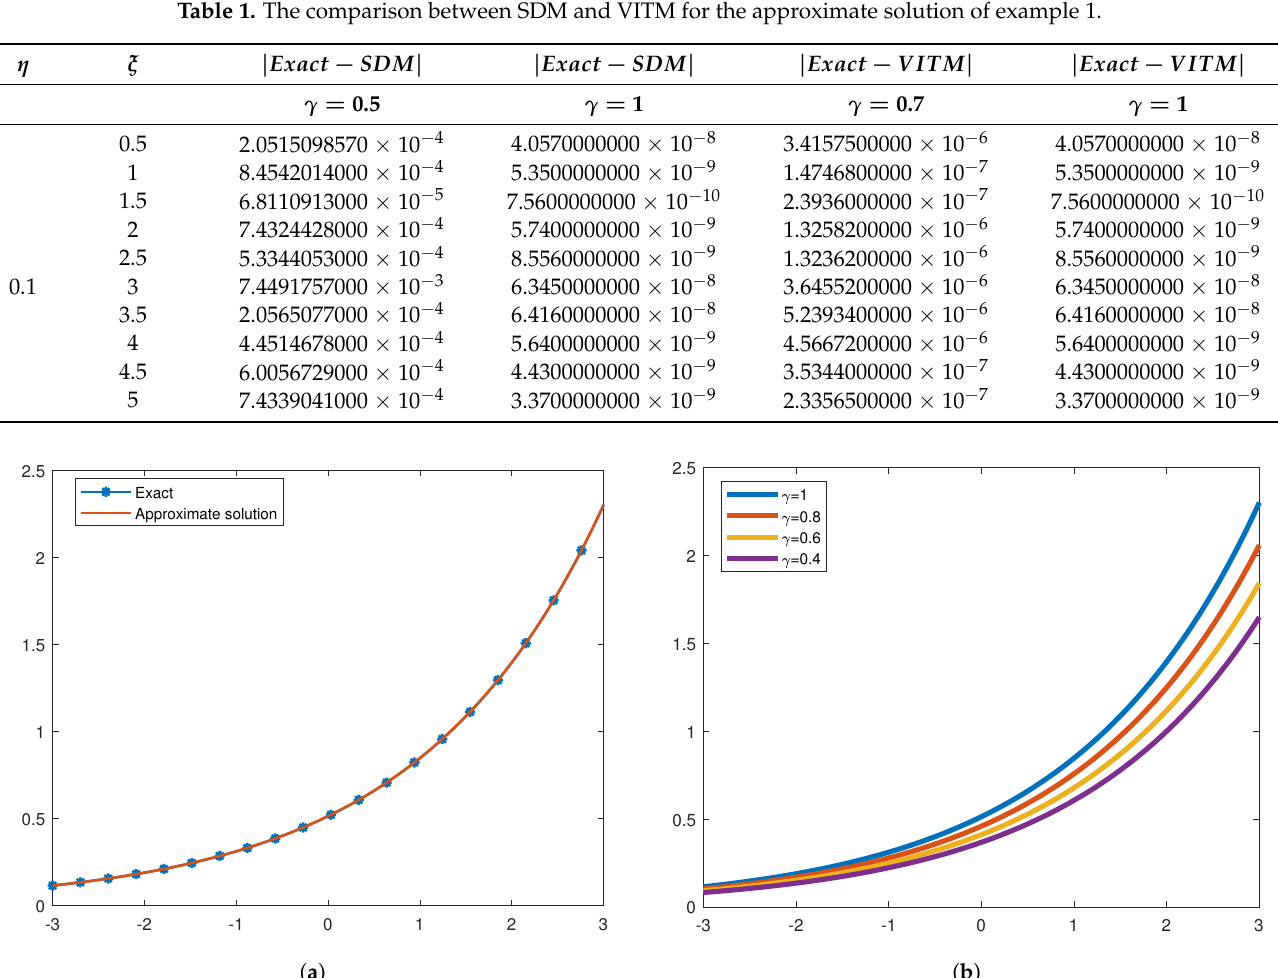
Figure 1. ( a ) Exact and approximate solution plot at γ = 1 of example 1. ( b ) Approximate solution plot of different fractional of example